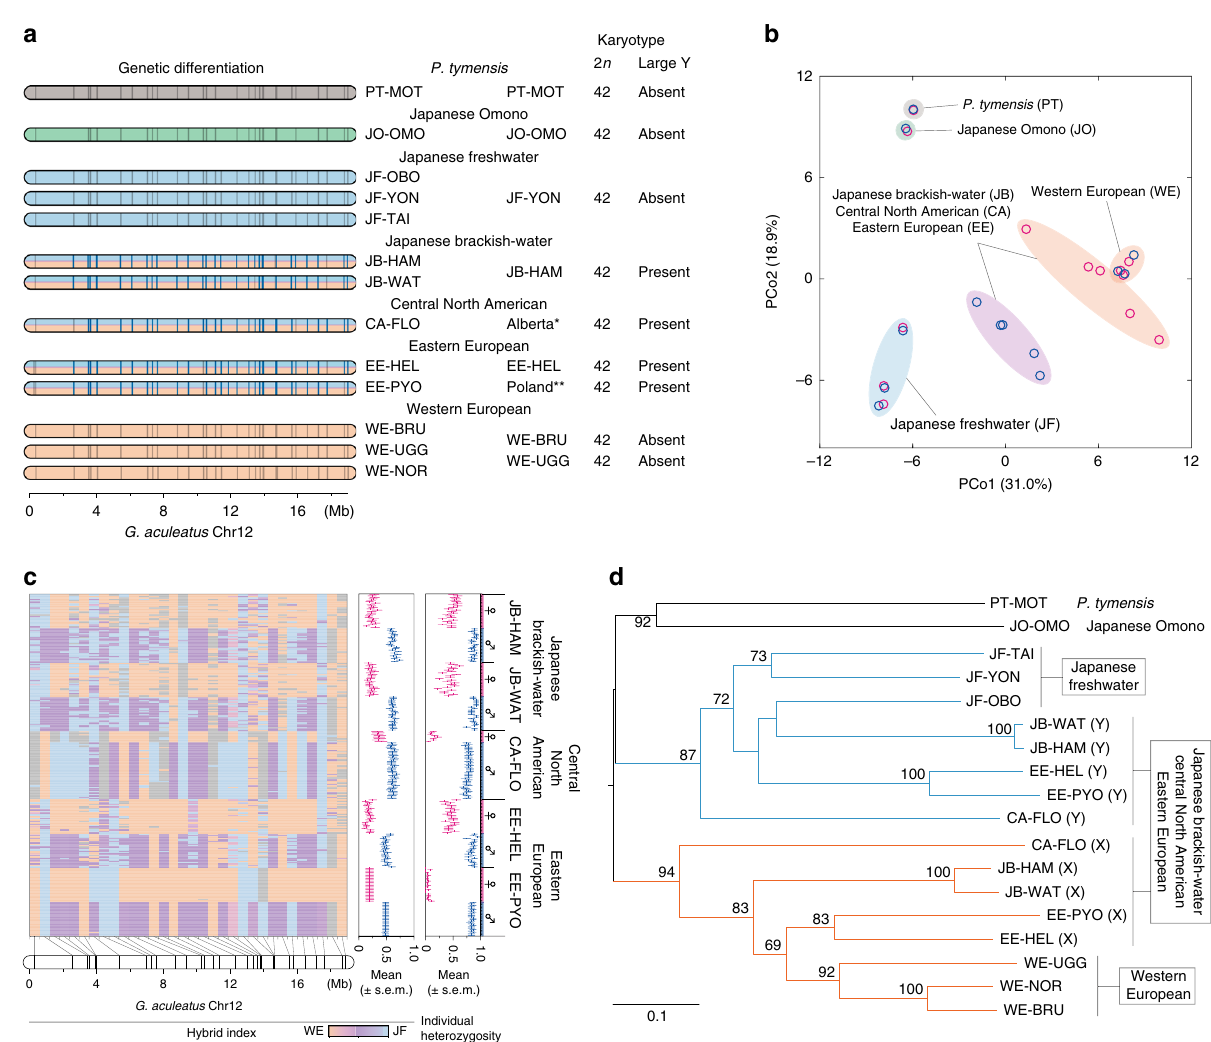
Fig. 3 Genetic differentiation and evolutionary relationships of X and Y chromosomes. a Sex-speci fi c genetic differentiation in the region of G. aculeatus Chr12 and the presence or absence of a large male-speci fi c chromosome in 13 populations from seven lineages. Loci with male-speci fi c alleles are indicated in blue. Locus positions are based on the G. aculeatus genome. Different chromosome colors represent different origins, as indicated by phylogenetic analyses based on G. aculeatus Chr12 loci (see d ). Karyotype data for Alberta* and Poland** are based on Ross et al. 15 . and Ocalewicz et al. 16 , respectively. b Principal coordinate analysis among 13 populations. PCo1 and PCo2 values are plotted on the x and y axes, respectively. Females (red) and males (blue) are indicated separately. c The hybrid index and individual heterozygosity of each individual from fi ve populations belonging to three lineages with an XY sex determination system. Hybrid index estimates are given for each locus. The hybrid index is expected to be 0 or 1 when a locus has two alleles unique to the WE or JF lineages, respectively, and 0.5 when a locus has two alleles, each of which is present in a different lineage. The hybrid index level for each locus is represented with a color gradient. Uninformative loci are shown in gray. Mean hybrid index values and individual heterozygosity are given for each individual. Bars represent standard error of the mean. Female and male individuals are shown in red and blue, respectively. d Phylogenetic relationships among 13 populations based on G. aculeatus Chr12 loci. X- and Y-chromosomal haplotype data are used for three lineages with an XY sex determination system. Bootstrap values ( ≥ 60) are given near the nodes. The tree is rooted at the